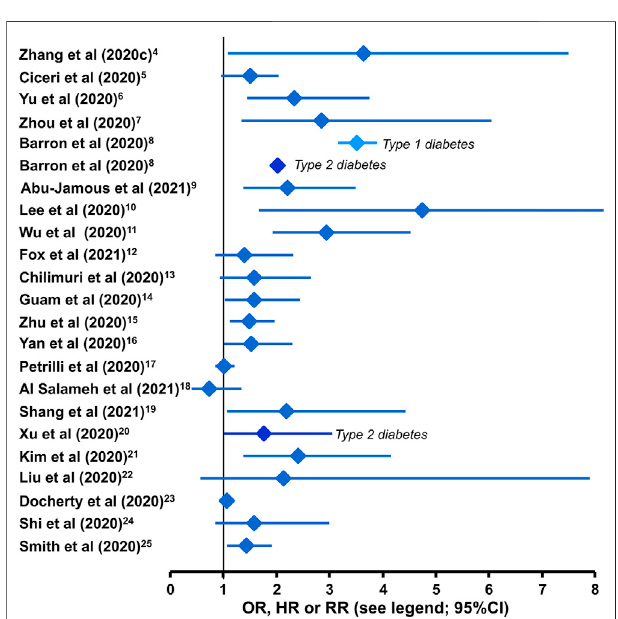
FIGURE 1 | Impact of comorbid diabetes on the risk of mortality from Covid-19. Studies reporting morality outcomes [or composite of death, renal replacement therapy/haemodialysis, ventilation, intubation or use of vasopressor (Abu-Jamous et al., 2021)] are hazard ratios [HR